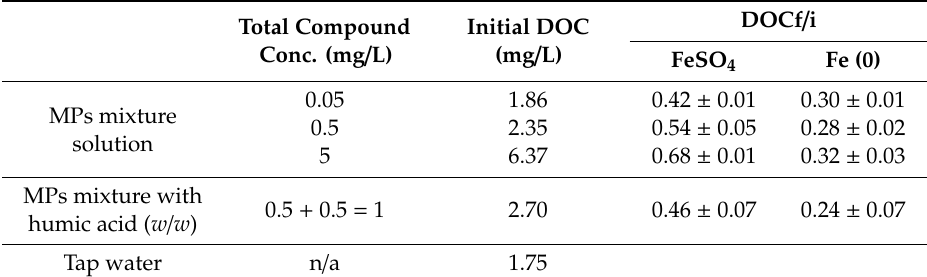
Table 9. DOCf / i factor value after Fenton oxidation runs at optimal levels of designed parameters.